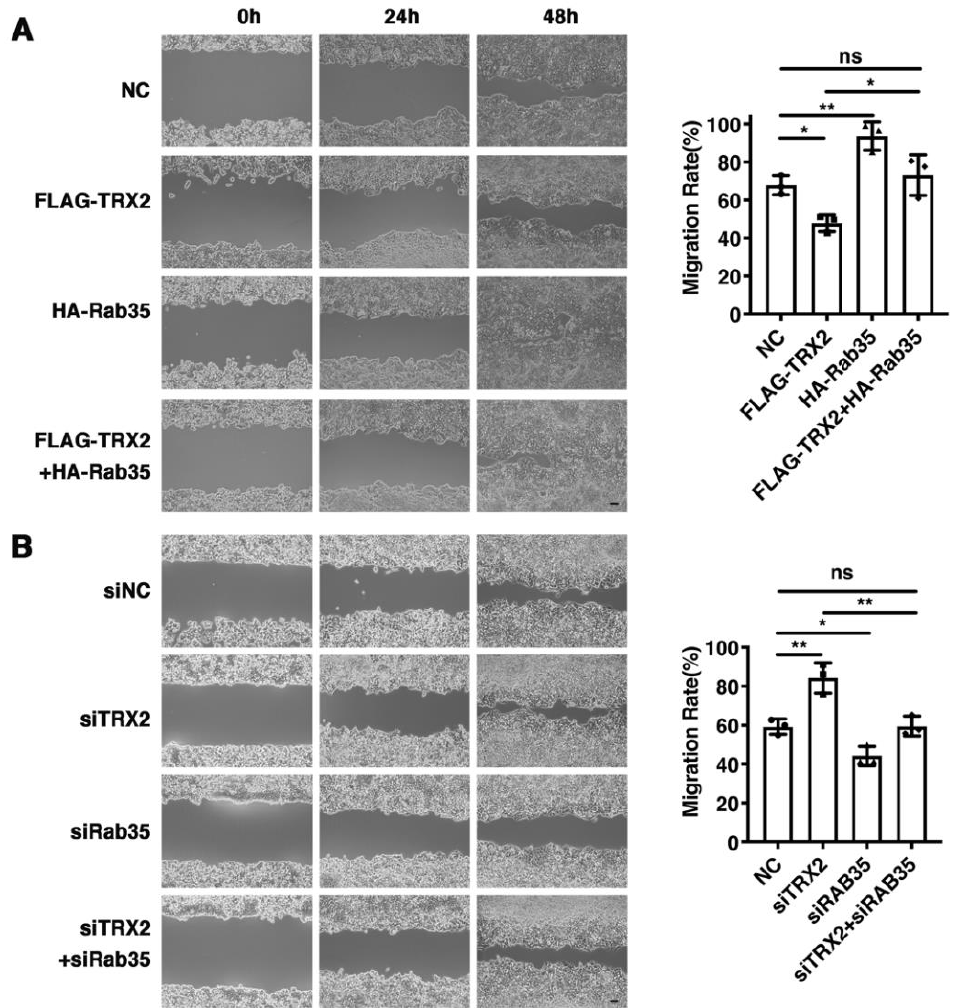
Figure 6. Rab35 mediated the TRX2-induced suppression of cell migration. ( A ) HCT116 cells were transfected with pcDNA3.1+, FLAG-TRX2, or HA-Rab35. Cell migration was measured by scratch tests. ( B ) HCT116 cells were transfected with siNC, siTRX2, or siRab35. Cell migration was measured by scratch tests. The experiments were performed for three biological replicates. The error bars represent means ± SD. ns, no significant difference; * p < 0.05 and ** p < 0.01 using one-way ANOVA with Šídák’s multiple comparisons test.